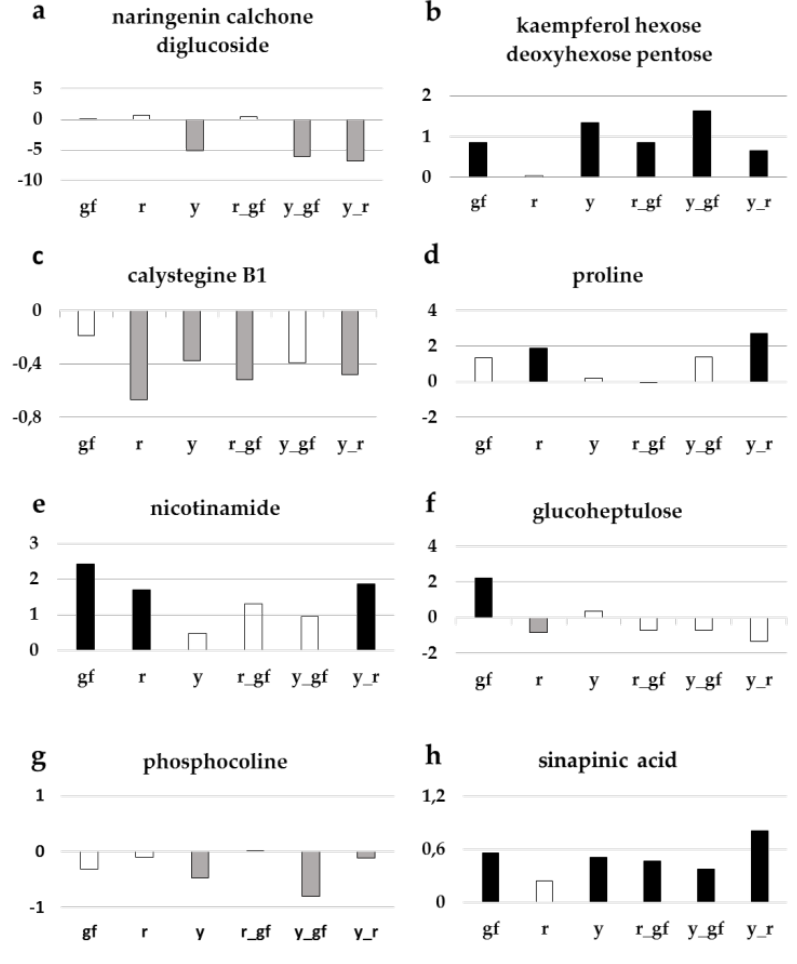
Figure 6. Relative log2 variation in ( a ) naringenin chalcone glucoside, ( b ) kaempferol-hexose-deoxyhexose-pentose, ( c ) calystegine B1, ( d ) proline, ( e ) nicotinamide, ( f ) glucoheptulose, ( g ) phosphocoline, ( h ) sinapinic acid, of six fruit mutant lines in San Marzano (SM) background compared with the recurrent parent. Line symbols are reported in Table 1. Bars colored in grey and black indicate means significantly lower and higher than SM for p ≤ 0.05 after Student’s t -test,